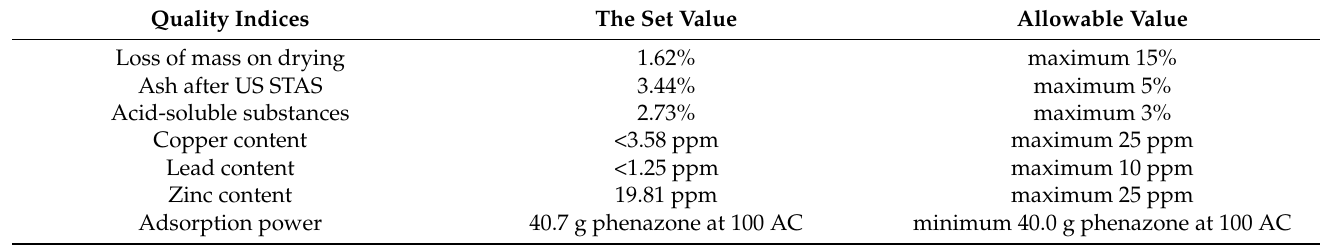
Table 2. Quality indices of the AC-A enterosorbent.